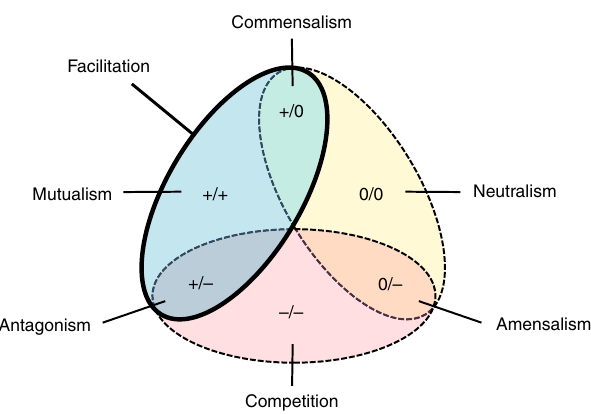
context of facilitation should increase our understanding about infection outcomes. On the other hand, because it is organisms (given their shorter generation time), studies of symbiont – symbiont facilitation may guide predictions about how positive interactions between species could shape evolution in